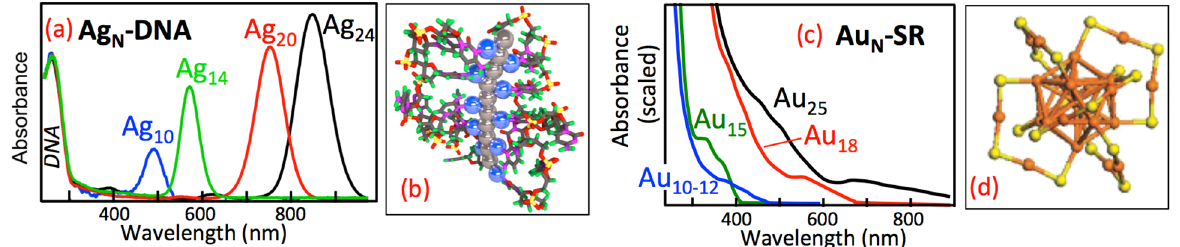
Figure 1. Experimental absorbance spectra are strikingly different for ligand-protected clusters composed of the same number of metal atoms but with different shapes and type of metal. ( a ) Ag N clusters protected by different DNA template strands each display a single, narrow absorbance transition beyond the 260 nm DNA peak [14]; ( b ) A proposed Ag N -DNA structure [14], whose neutral cluster core (gray) is held by base-bound Ag + (blue). The depicted rod cluster shape reproduces the striking spectral purity and size-dependent colors that are characteristic of Ag N -DNA; ( c ) The broad spectra of Au N -SR clusters protected by thiolate (SR) ligands reflect their globular cluster shape and Au composition. (Adapted from reference [15] and reprinted with permission); ( d ) The globular core of Au N -SR is protected by SR ligands that incorporate additional Au atoms. Orange: Au. Yellow: S. (R groups not shown). (Adapted with permission from reference